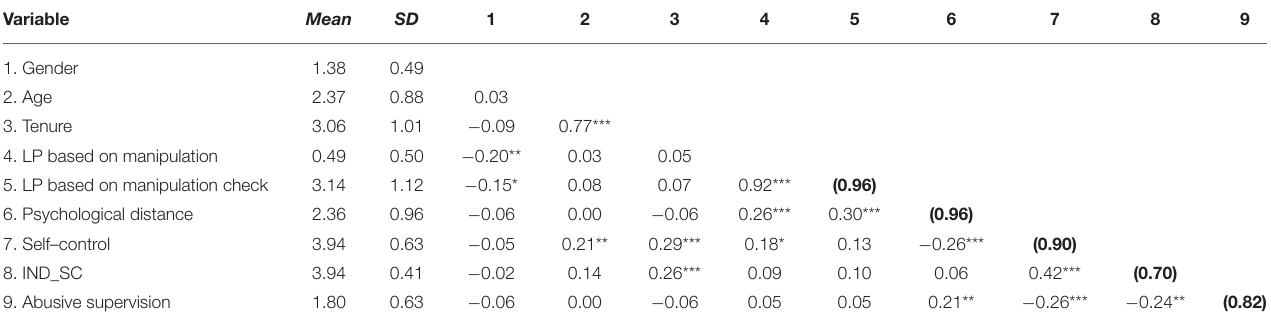
TABLE 3 | Descriptive statistics and correlations of Study 2. Variable